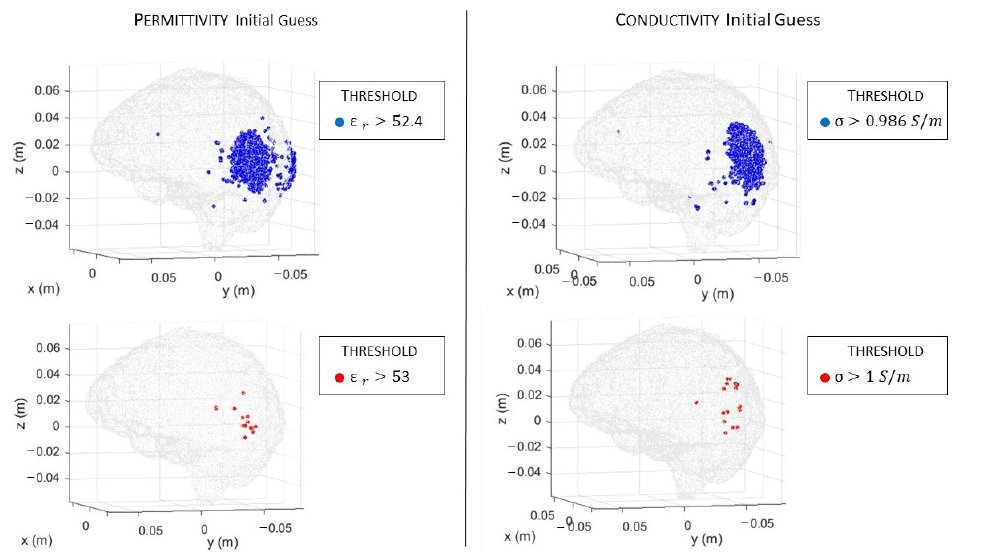
Figure 9. CSI algorithm initial guess with the proposed discretization. On the first row, in blue, the region of the stroke identified by the algorithm, and on the second row, in red, the spots with higher dielectric properties values: on the left, permittivity, and on the right, conductivity.